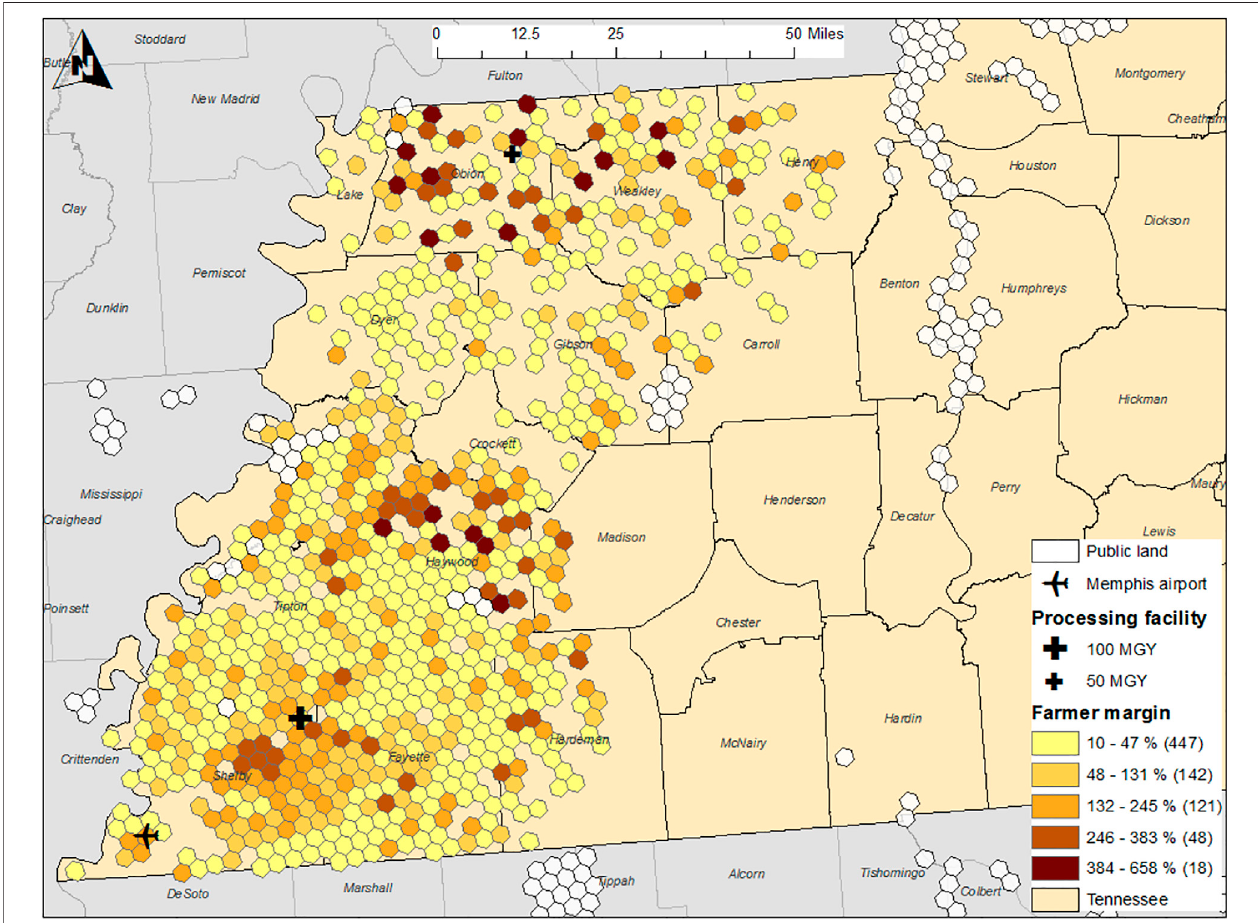
FIGURE 3 | Margins of individual feedstock producers under the Baseline. Note: Number in the parenthesis refers the amount of feedstock producers.